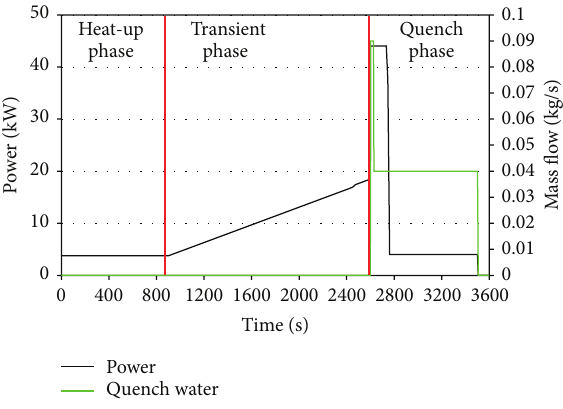
Figure 3: Progression of the QUENCH-03 test